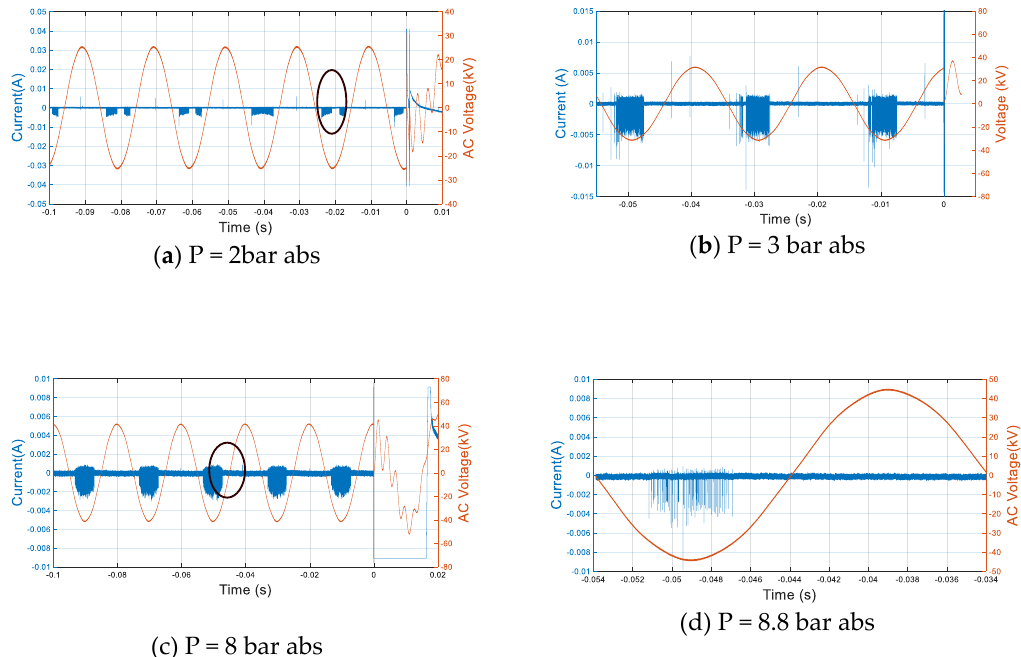
Figure 5. Voltage-current waveform for measuring partial discharge and breakdown voltages in CO 2 . Table 2. AC Breakdown polarity of CO 2 and 4%Novec TM 4710/96%CO 2 under different pressures up to 8.8 bar abs (Needle on HV Electrode).